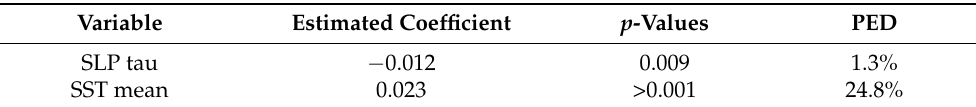
Table 3. Relationship between trends in MH variability and physical